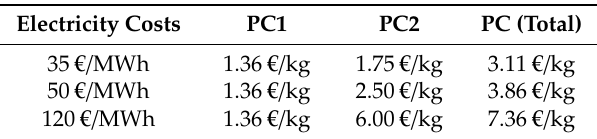
Table 3. Hydrogen production price depending on the price of electric energy. PC1 refers to P2G